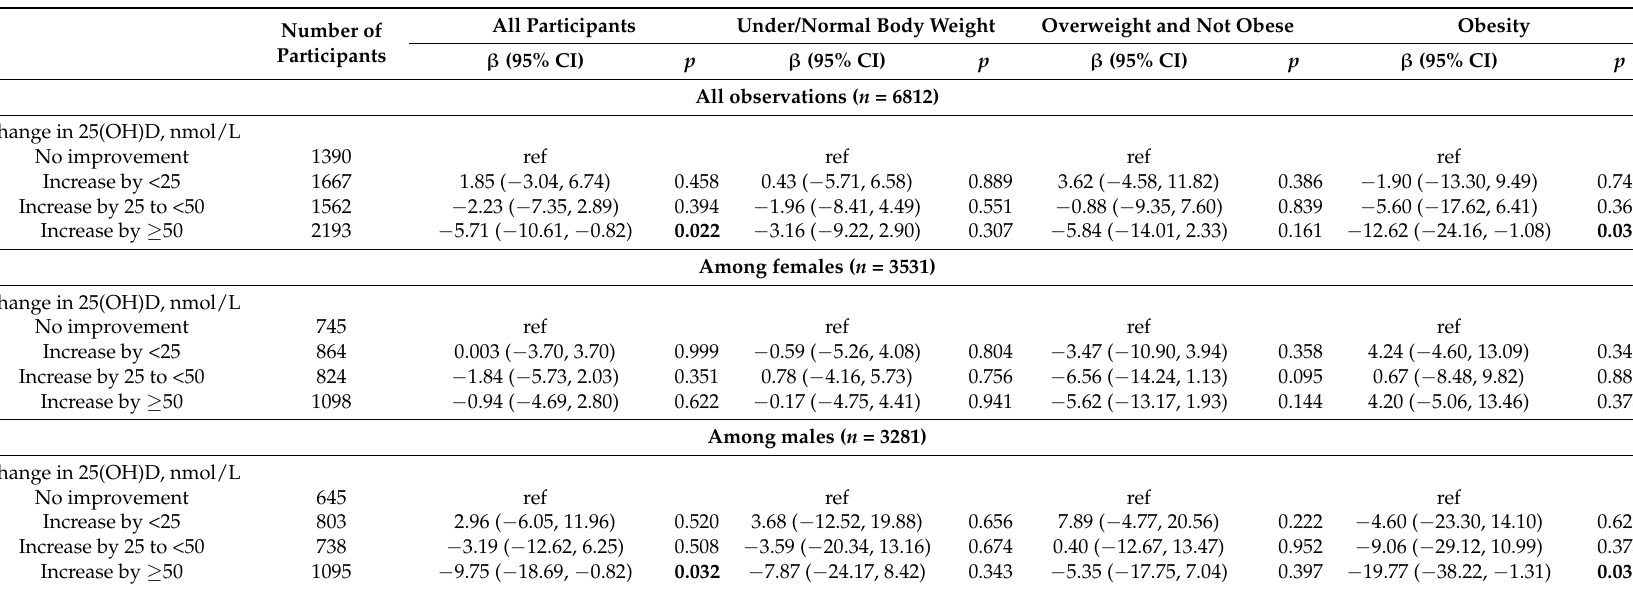
p -values from multiple linear regression model were adjusted for baseline serum ferritin, baseline serum 25(OH)D concentration, baseline age, baseline body weight status (except the analyses stratified by body weight status), baseline blood pressure status, baseline smoking status, baseline alcohol status, baseline physical activity level, ethnicity and gender (except the gender stratified